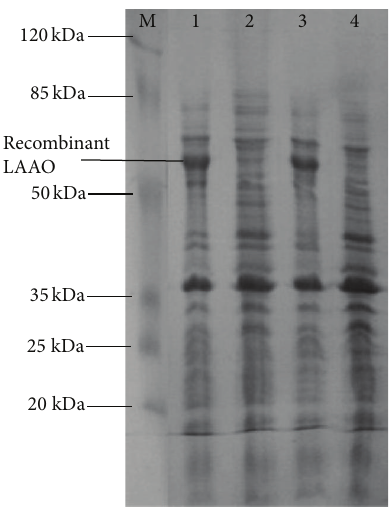
Figure 6: SDS-PAGE analysis of the expressed recombinant B3- LAAO in E. coli BL21(DE3). Lane M: prestained protein marker (Thermo, USA); lane 1: cell culture of E. coli BL21(DE3)/pET28b(+)- lao with a 6 h-induction by IPTG; lane 2: cell culture of E. coli BL21(DE3)/pET28b(+)- lao without induction; lane 3: cell culture of E. coli BL21(DE3)/pET20b(+)- lao with a 6 h-induction by IPTG; Lane 4: cell culture of E. coli BL21(DE3)/pET20b(+)- lao without